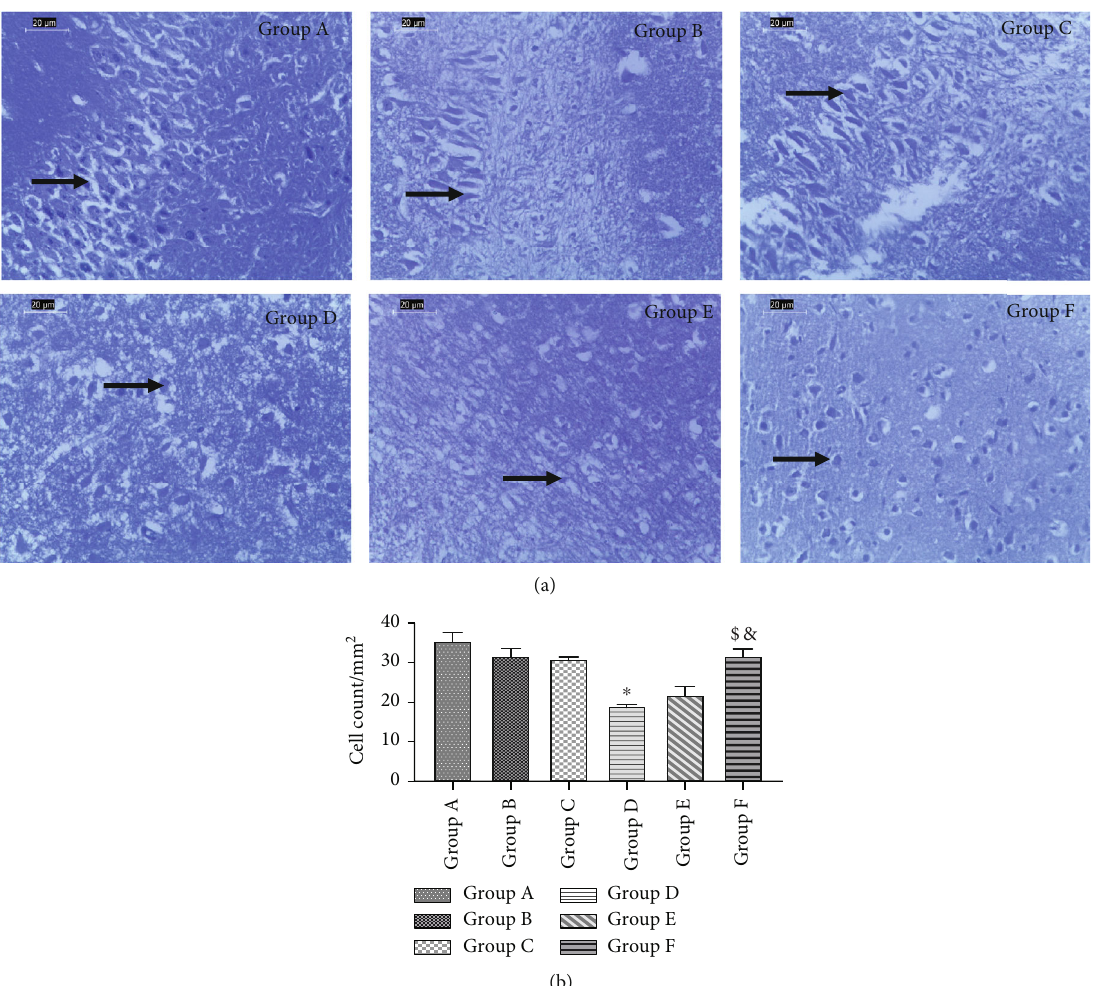
Figure 9: (a) Hippocampus CA1 Nissl staining histology ( × 400). A=nondiabetic control showing distinct pyramidal cells with well-stained Nissl bodies. B=nondiabetic+HAART showing pyramidal cells with mildly stained Nissl bodies. C=nondiabetic+HAART-AgNPs showing pyramidal cells with distinct stained Nissl bodies. D=diabetic control showing necrotic pyramidal cells with poorly stained Nissl bodies. E =diabetic+HAART showing pyramidal cells with mildly stained Nissl bodies and vacuolated neurons. F=diabetic+HAART-AgNPs showing pyramidal cells with distinct stained Nissl bodies. (b) Population of Nissl-stained neurons in the hippocampal CA1. Data are expressed as mean ± SEM ( n = 8 ); ∗ p < 0 : 05 vs. group A (nondiabetic control), & p < 0 : 05 vs. group D (diabetic control); $ p < 0 : 05 vs. group E (diabetic+HAART).